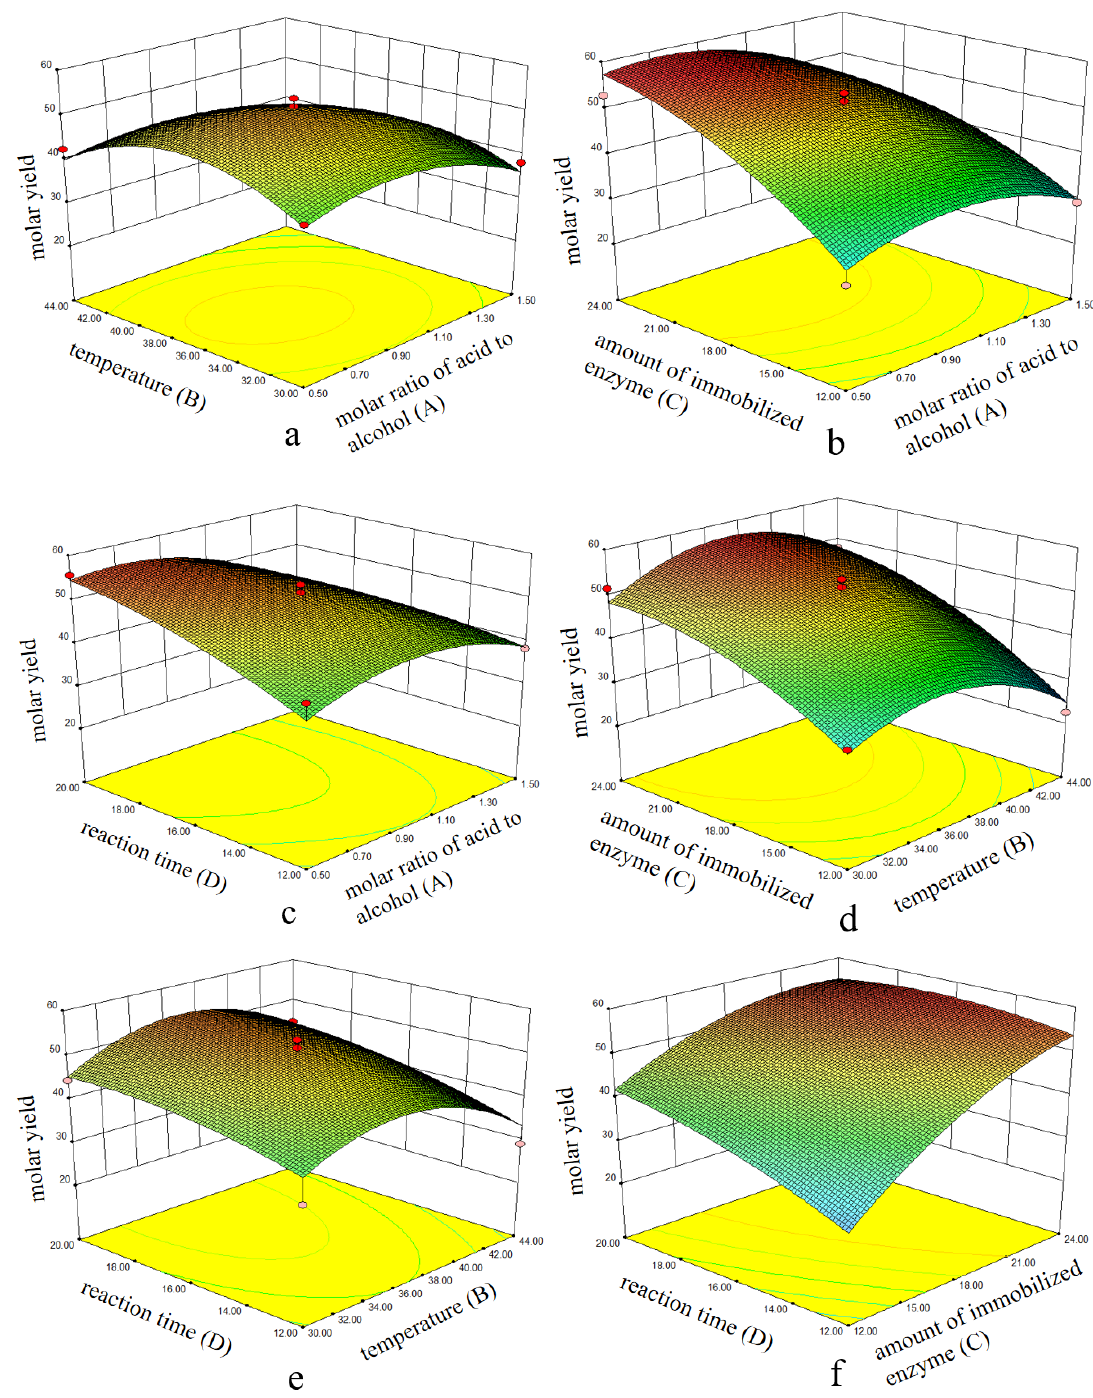
Figure 8. Response surface plot and contour plot for synthesis of isopropyl myristate by immobi- lized enzyme showing significant model terms: ( a ) temperature vs. molar ratio of acid to alcohol, ( b ) amount of immobilized enzyme vs. molar ratio of acid to alcohol, ( c ) reaction time vs. molar ratio of acid to alcohol, ( d ) amount of immobilized enzyme vs. temperature, ( e ) reaction time vs. temperature, and ( f ) reaction time vs. amount of immobilized enzyme.